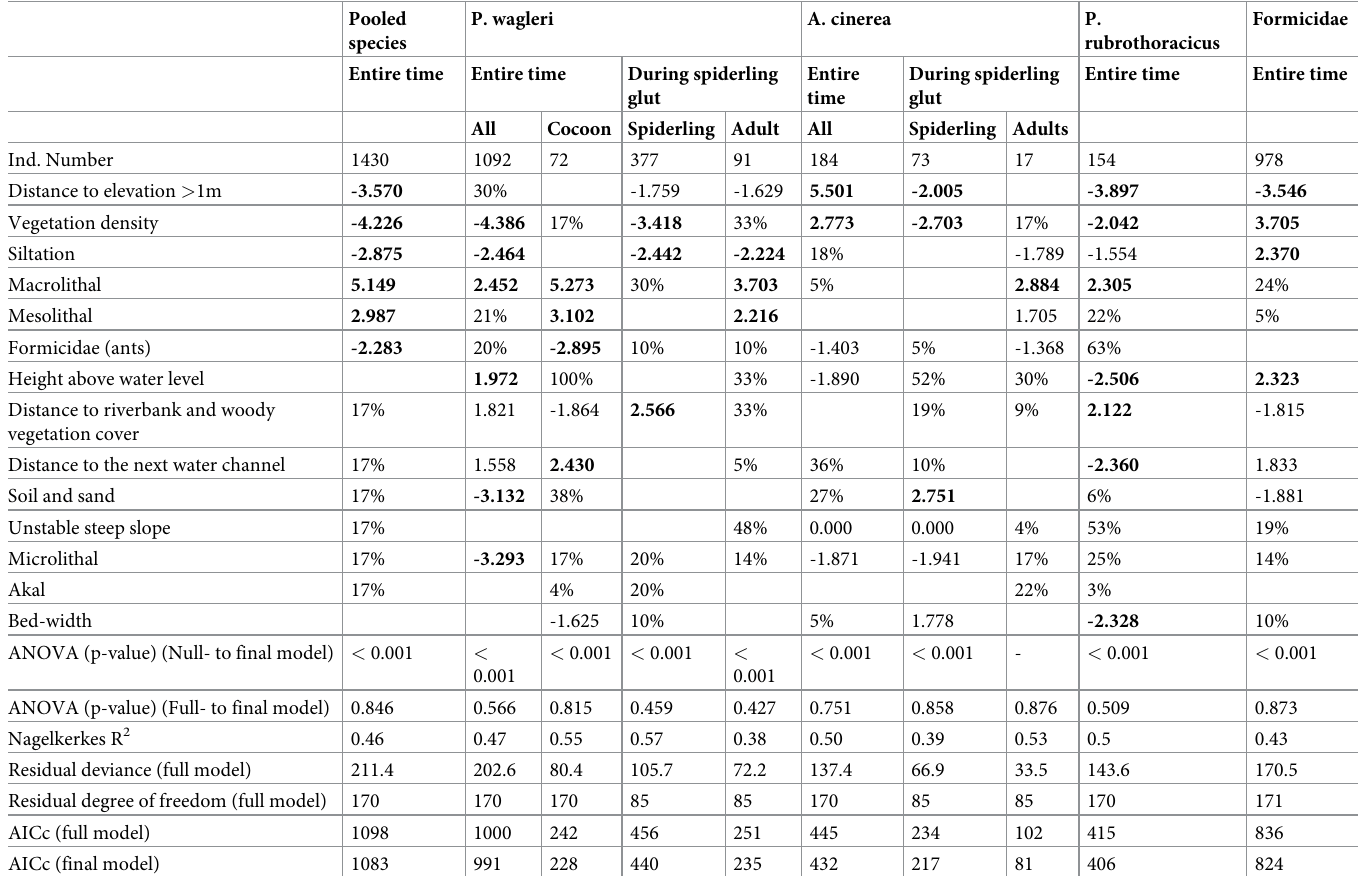
Table 2. Results of the final models for the pooled species approach, the three model species and for ants (Formicidae). Models for the two spider species were calcu- lated based on all samplesand on samples taken in the second half of the sampling period. The numbers represents the z-value (estimate/ standard error) for each variable given by the dredged negative binomial regression. Significant results are given in bold. Percentages represent the relative proportion of occurrences of the variable in com- peting models with delta AICc < 2)